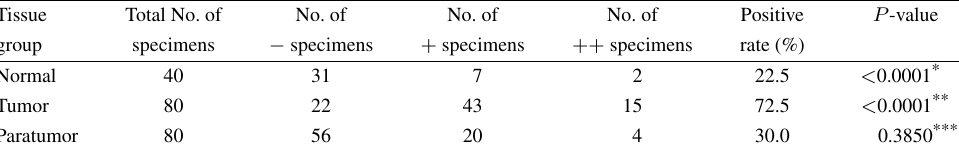
Detection of E2F-1 protein expression in gastric tumor, paratumor, and normal gastric tissues by immunohistochemistry Tissue